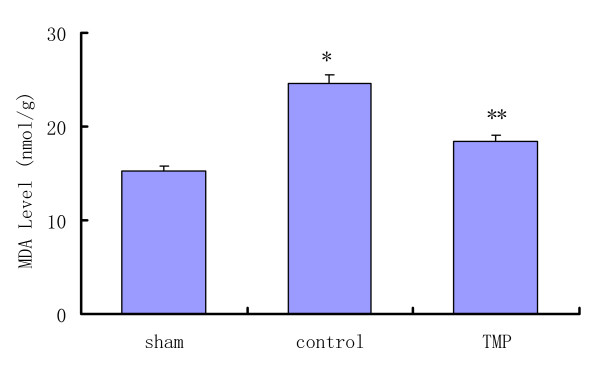
Effects of TMP on MDA Level at the 48th hour reperfusion. The MDA level of spinal cord in sham group, Control group and TMP group was determined as described under Methods. Average value and SD are shown, N = 3.*P < 0.01, vs sham group; **P < 0.01, vs control group.